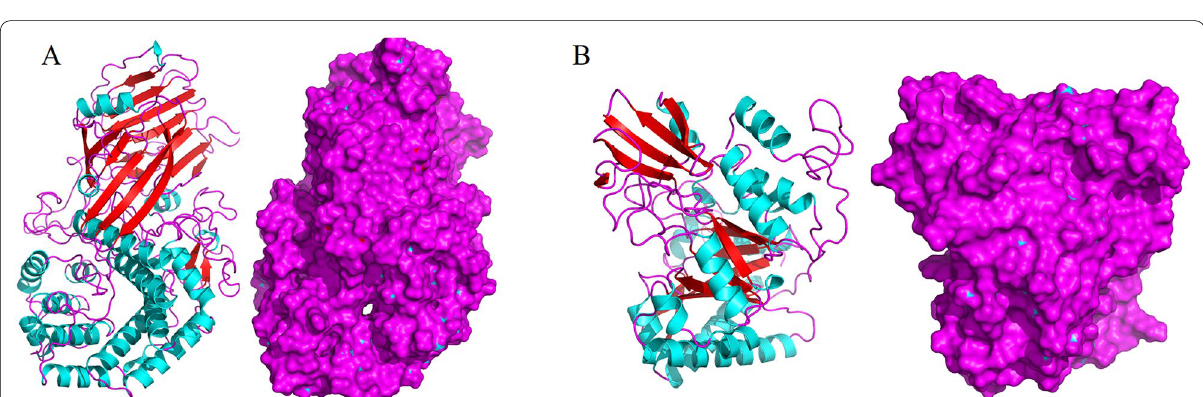
Fig. 4 Model of A hydrGB10I (hydrolase) and B chitGB10I (chitinase) visualized within the PyMOL based on results of homology modelling obtained from RaptorX and COACH servers. Models present the three-dimensional structure of proteins. The secondary structure elements are coloured in blue (α-helices), red (β-sheets) and pink (loops). The surface structure is coloured in